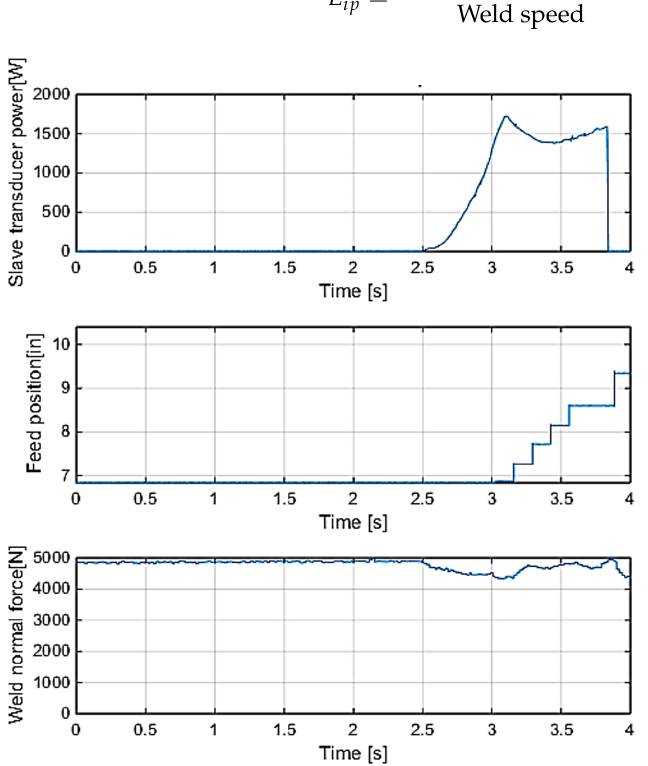
Figure 11. Weld power, X-position of the workpiece, and weld force as recorded by NI 9239 sampled at 50 kHz for the following weld parameters: 35 µ m welder amplitude, 5000 N weld force, and 84.67 mm/s (200 in/min) weld